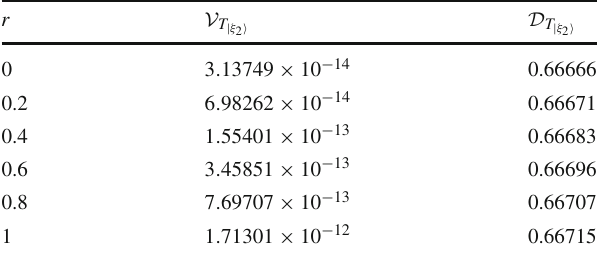
Fig. 5 Behaviour of D T | ξ is plotted for the same range of r and 2 (cid:3) e < 1 only choices of parameter p value as in Fig. 4. Note that D T | ξ 2 (cid:3) e ≈ 1 when r (cid:10) 1, otherwise D T | ξ 2 (cid:3) e Table 3 Numerical values of density fluctuations and dimensionless parameter in TMSV states for the squeezing parameter r